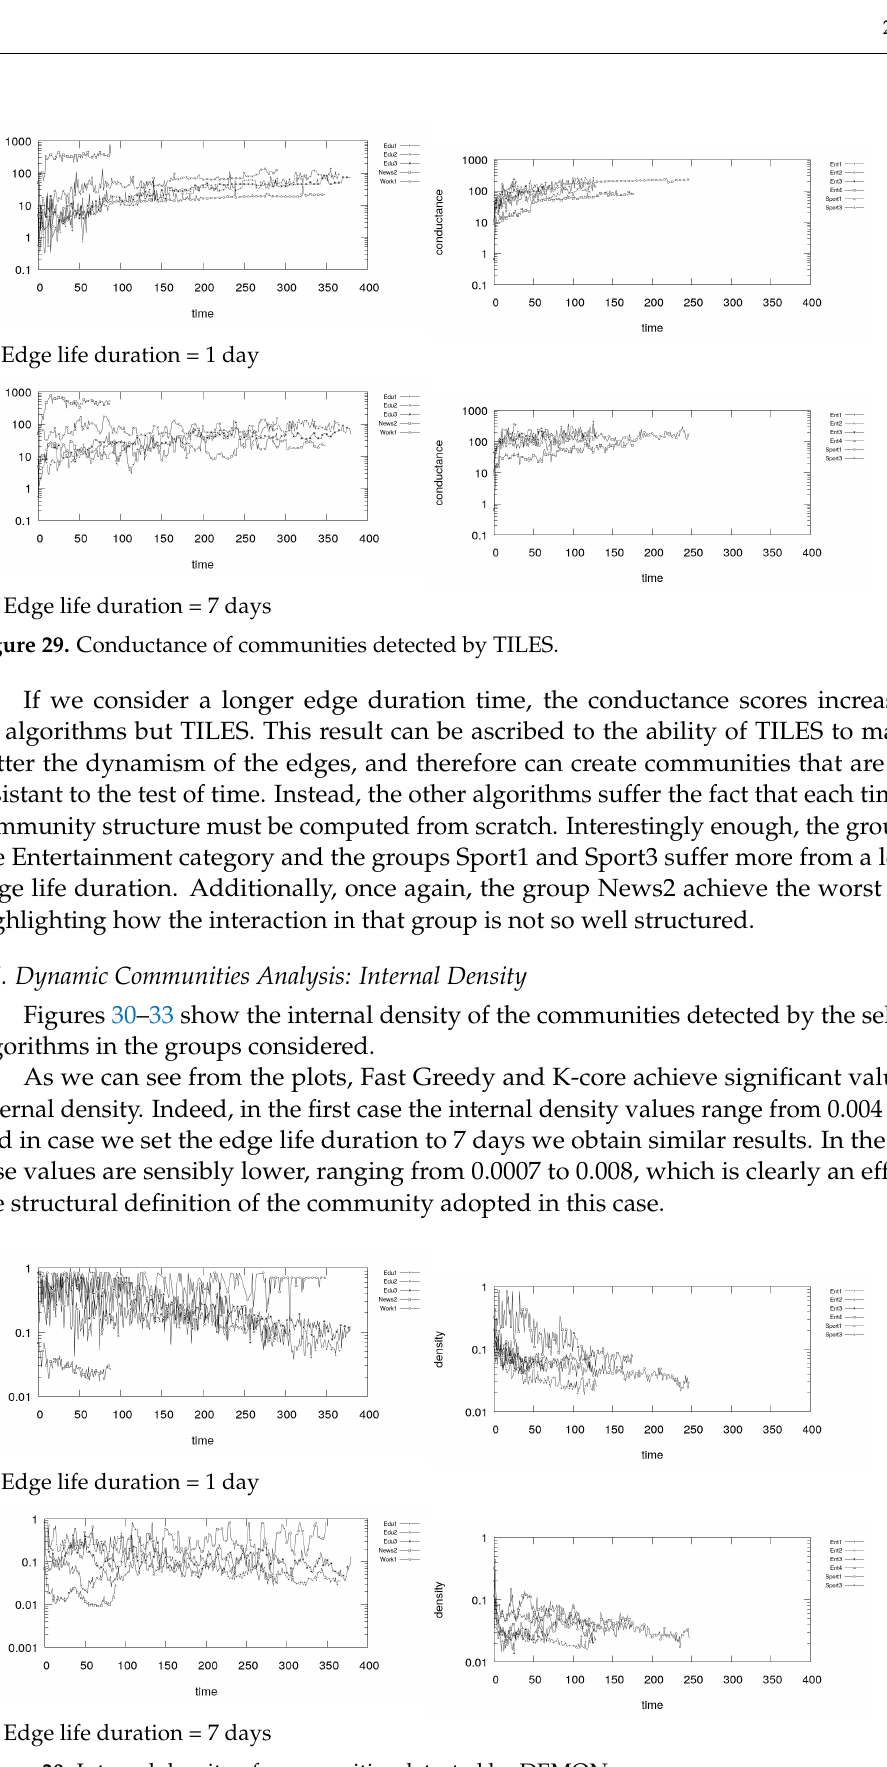
Figure 30. Internal density of communities detected by